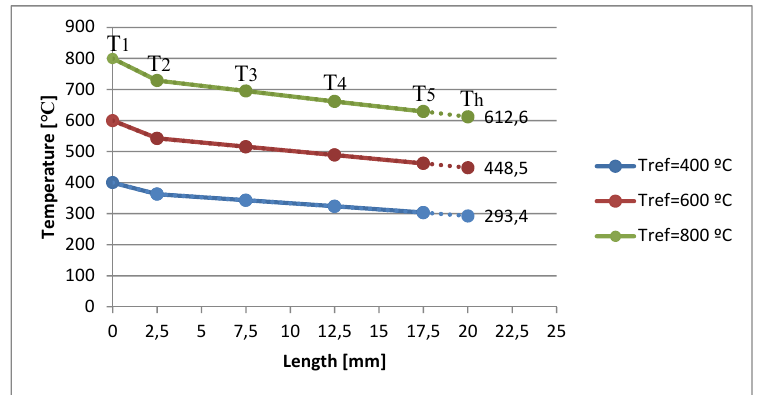
Figure 4. Temperature readings from thermocouple T 1 to T 5 and extrapolation of the CMO ‐ 25 ‐ 42S hot surface ( Th ) for input temperature references of 400 °C, 600 °C and 800 °C. All the described parts are sandwiched together between two plates at a desired pressure.